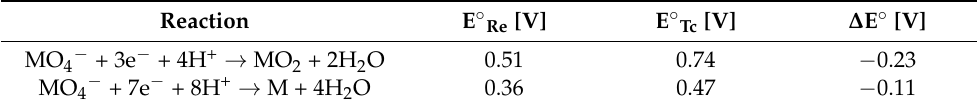
Table 3. Standard reduction potentials comparison (M = Re,